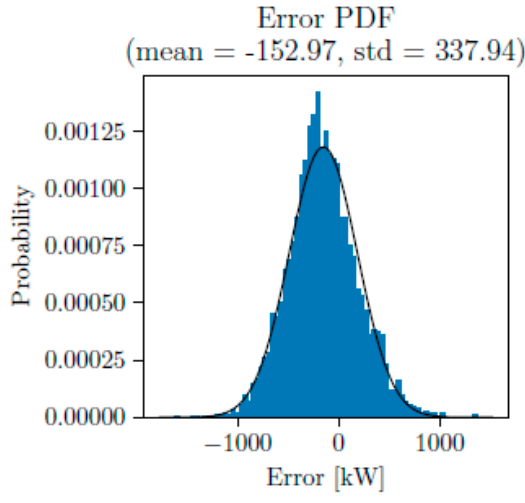
Figure 12. One-hour-ahead error distribution.